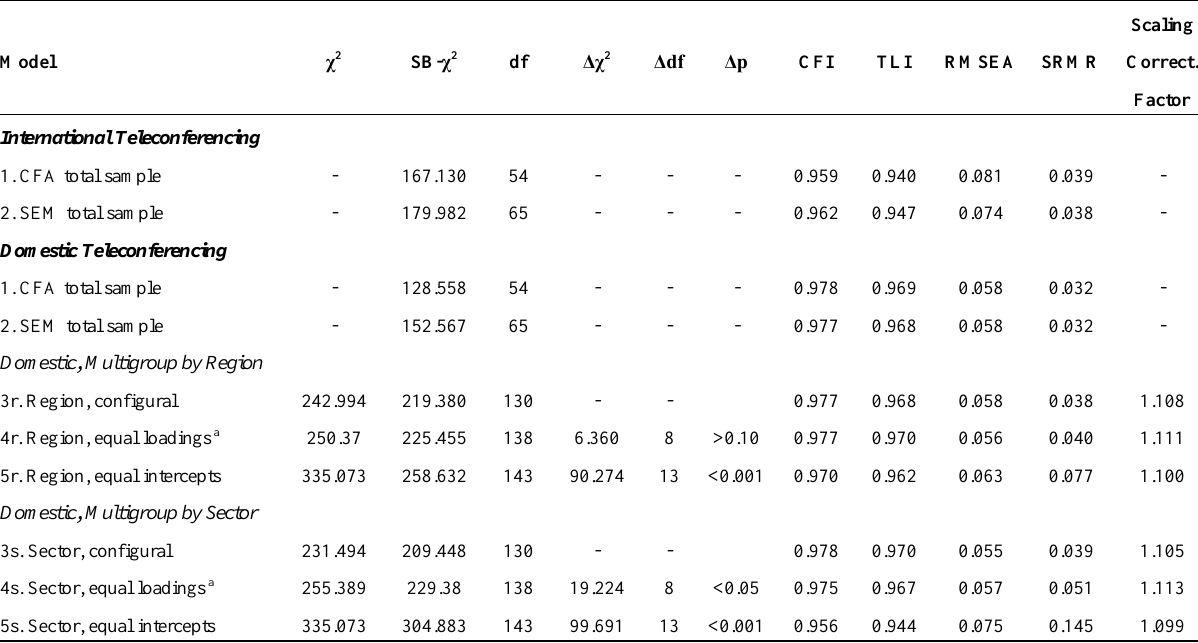
Table 4. Teleconferencing: goodness of fit